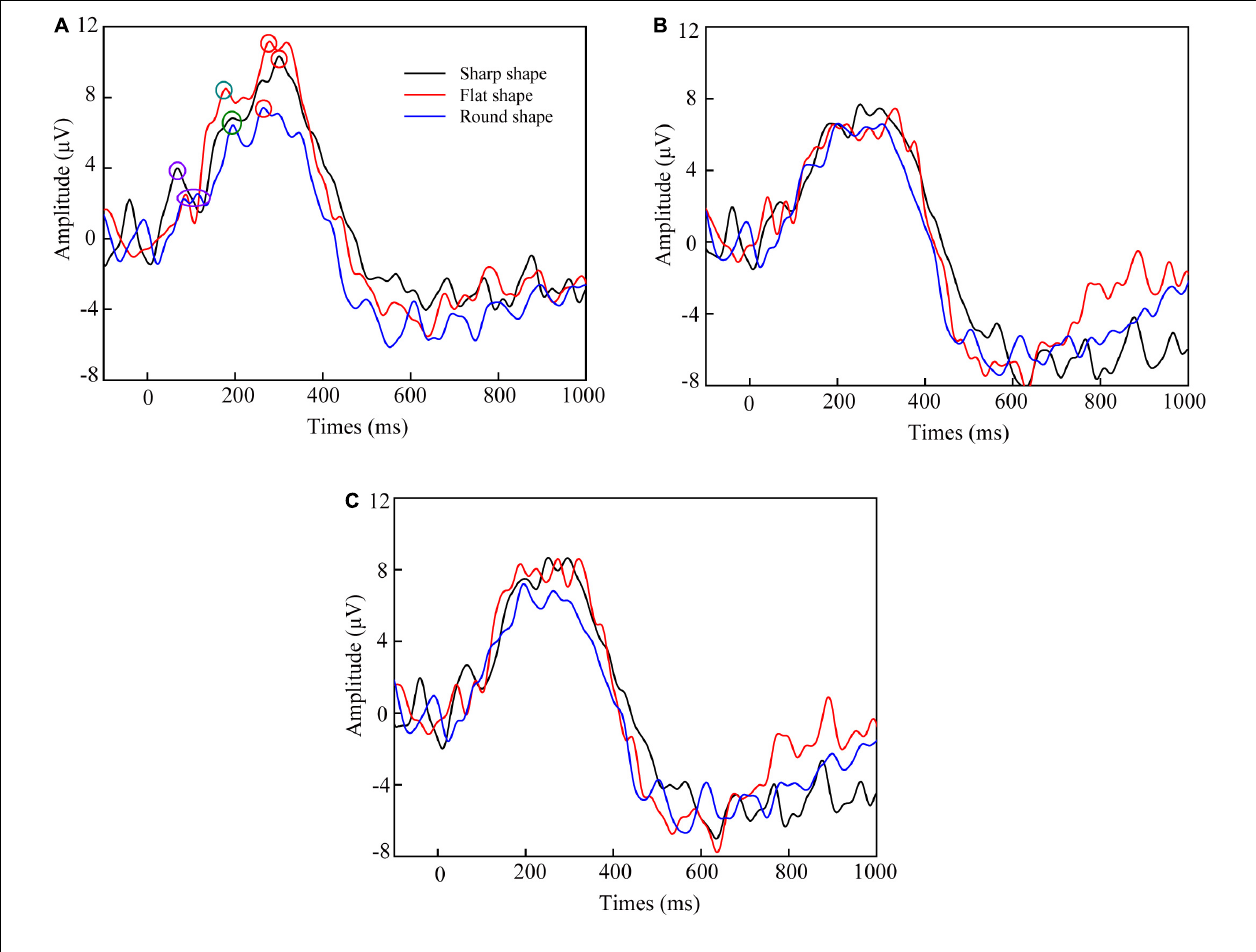
FIGURE 5 | Average ERP waveform of (A) C3, CP1, and P3 electrodes located in the left hemisphere, (B) C4, CP2, and P4 located in the right hemisphere, and (C) CZ and PZ located in the middle hemisphere. The purple, green, and red circle corresponded to the P100, P200, and P300 peak, respectively.